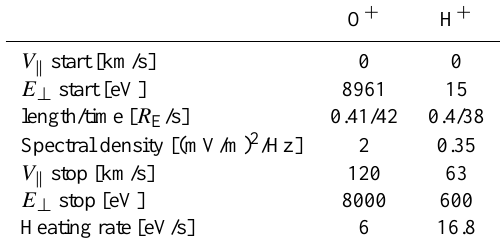
Table 1. Summary of the of backwards test particle calculation. The left column in the table shows the test particle calculation from the measured values (stop) down to the mirror point (start) for O + , and the right column shows the test particle calculation for H + .